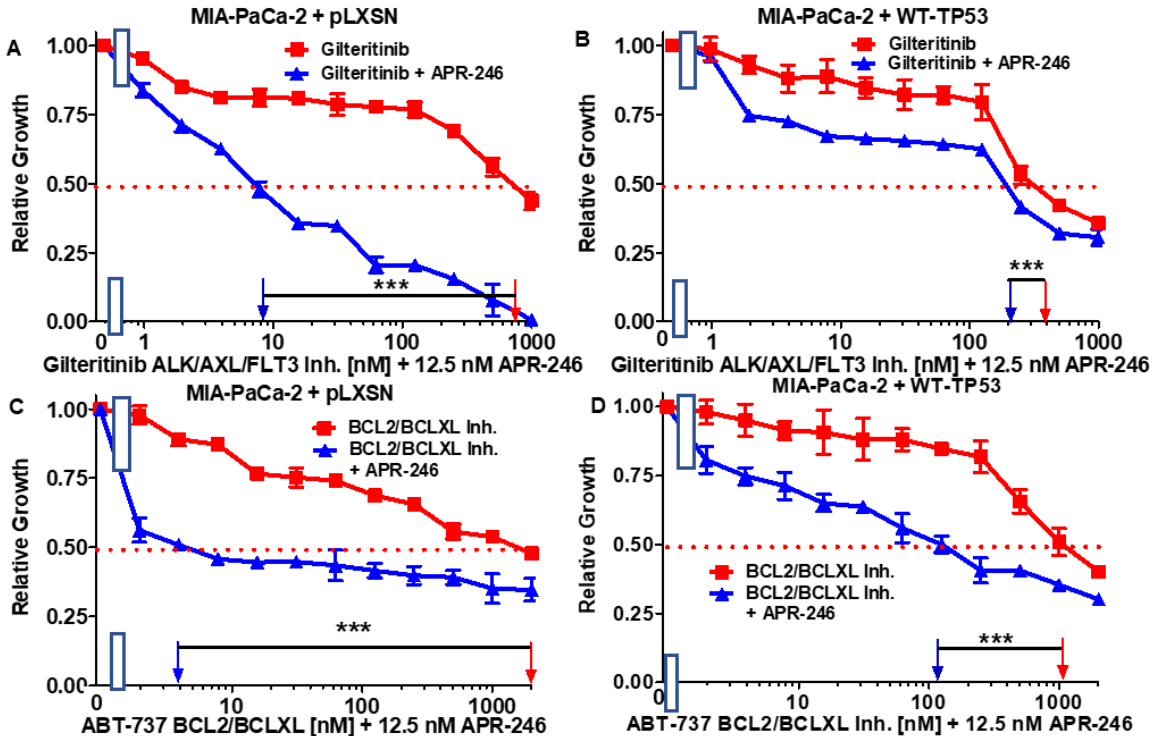
Figure 5. Effects of combining a low concentration of 12.5 nM APR-246 on the IC 50 values of gilteritinib and ABT-737 in MIA-PaCa-2 + pLXSN and MIA-PaCa-2 + WT-TP53 cells. Panel ( A ) MIA-PaCa-2 + pLXSN cells treated with different concentrations of gilteritinib (red squares) and MIA-PaCa-2 + pLXSN cells treated with different concentrations of gilteritinib and a low dose of 12.5 nM APR-246 (blue triangles). Panel ( B ) MIA-PaCa-2 + WT-TP53 cells treated with different concentrations of gilteritinib (red squares) and MIA-PaCa-2 + WT-TP53 cells treated with different concentrations of gilteritinib and a low dose of 12.5 nM APR-246 (blue triangles). Panel ( C ) MIA-PaCa-2 + pLXSN cells treated with different concentrations of ABT-737 (red squares) and MIA-PaCa-2 + pLXSN cells treated with different concentrations of gilteritinib and a low dose of 12.5 nM APR-246 (blue triangles). Panel ( D ) MIA-PaCa-2 + WT-TP53 cells treated with different concentrations of ABT-737 (red squares) and MIA-PaCa-2 + WT-TP53 cells treated with different concentrations of ABT-737 and a low dose of 12.5 nM APR-246 (blue triangles). *** = p <0.0001. Table 1. Effects of WT-TP53 on the sensitivity of MIA-PaCa-2 PDAC cells to APR-246 1 . MIA-PaCa-2 Drug/Agent + pLXSN ( − APR-246)